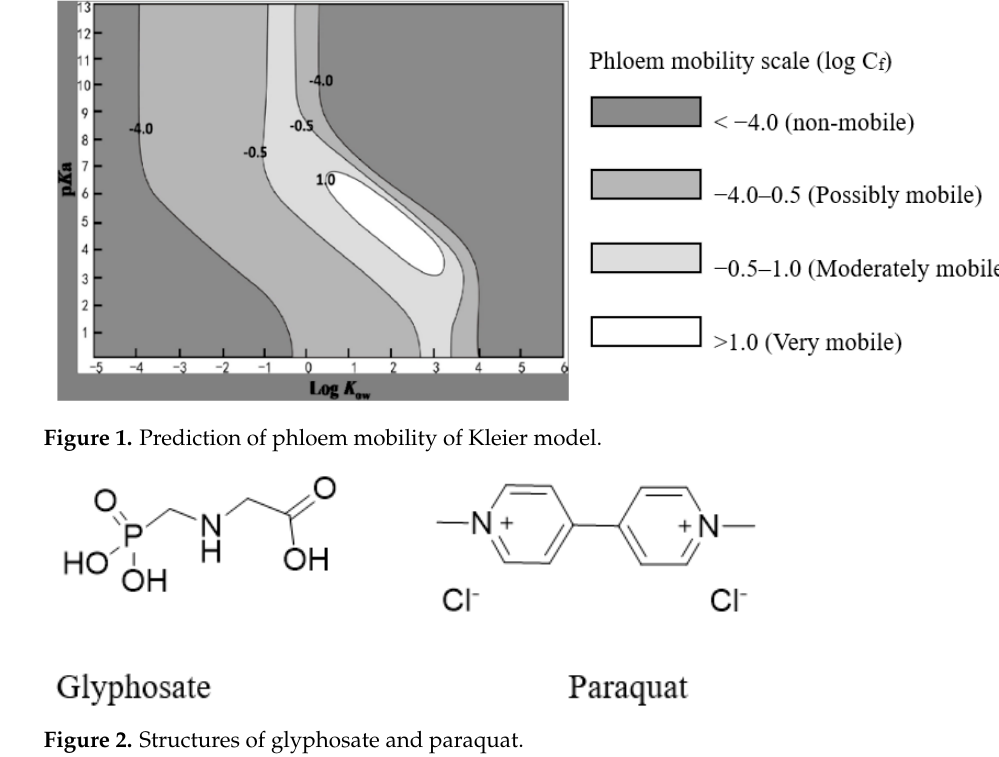
Figure 2. Structures of glyphosate and paraquat.